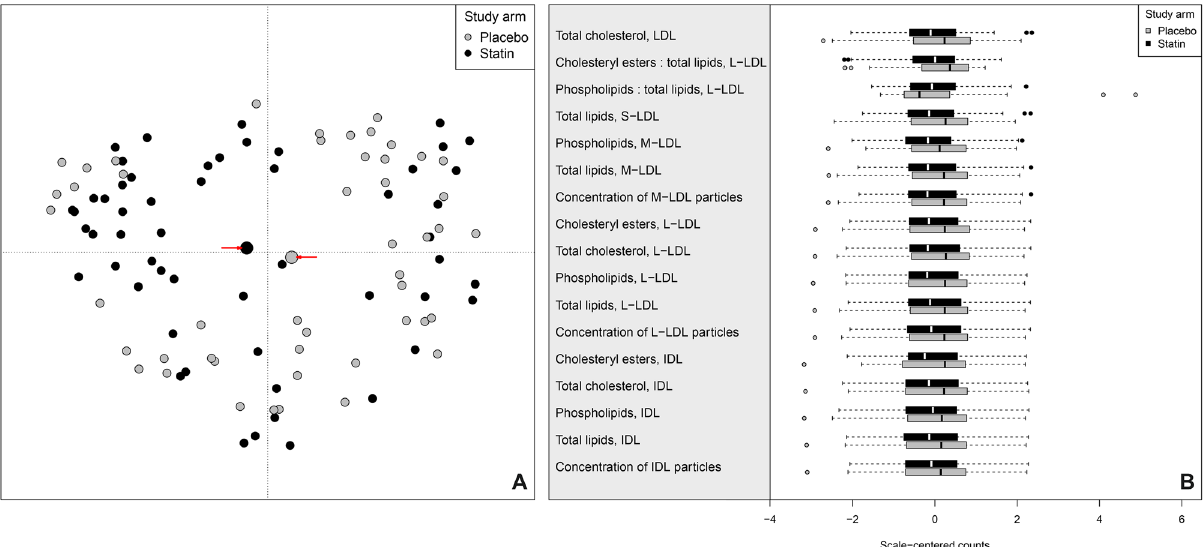
Figure 2. Baseline serum lipopoprotein subfraction lipid concentrations. ( A ) Proximity plot with baseline serum lipoprotein lipid patterns used as classifier results a random pattern. Random Forest classification proximity plot dimensions have no trivial interpretation therefore the names of the axes are disabled. The grey large point is the centroid (highlighted with arrows) for the placebo group and black for the statin group; the further away the centroids are, the more distinct the two classes are with respect to each other. ( B ) The baseline serum lipoprotein profiles shows equal distribution between the study arms as the median (thick bar inside a box) and dispersion (width of the box and the whiskers) are nearly overlapping. The outlying points outside the whisker region are defined as 1.5 interquartile range from either the bottom or the top quartile. The displayed metabolites are selected according to top-performing RFC classifiers in the serum metabolome after the